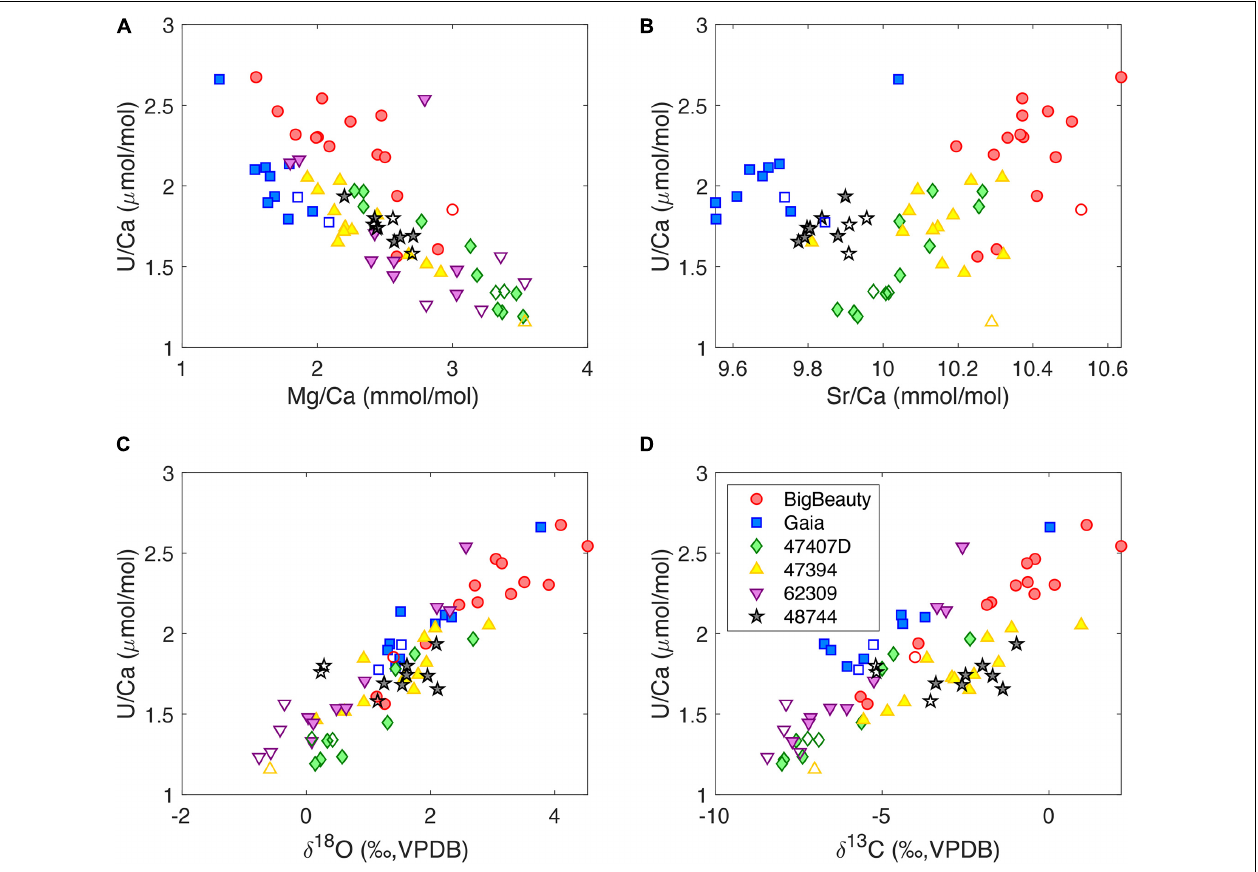
FIGURE 3 | U/Ca correlations with (A) Mg/Ca, (B) Sr/Ca, (C) δ 18 O and (D) δ 13 C in individual D. dianthus from micromilling. The filled symbols represent the secondary aragonite bands, while the open symbols represent COCs and COC-like bands. Coral 62309 was measured at St. Andrews while the others were measured at Caltech. There are analytical problems with Sr/Ca for 62309 and its Sr/Ca data are not